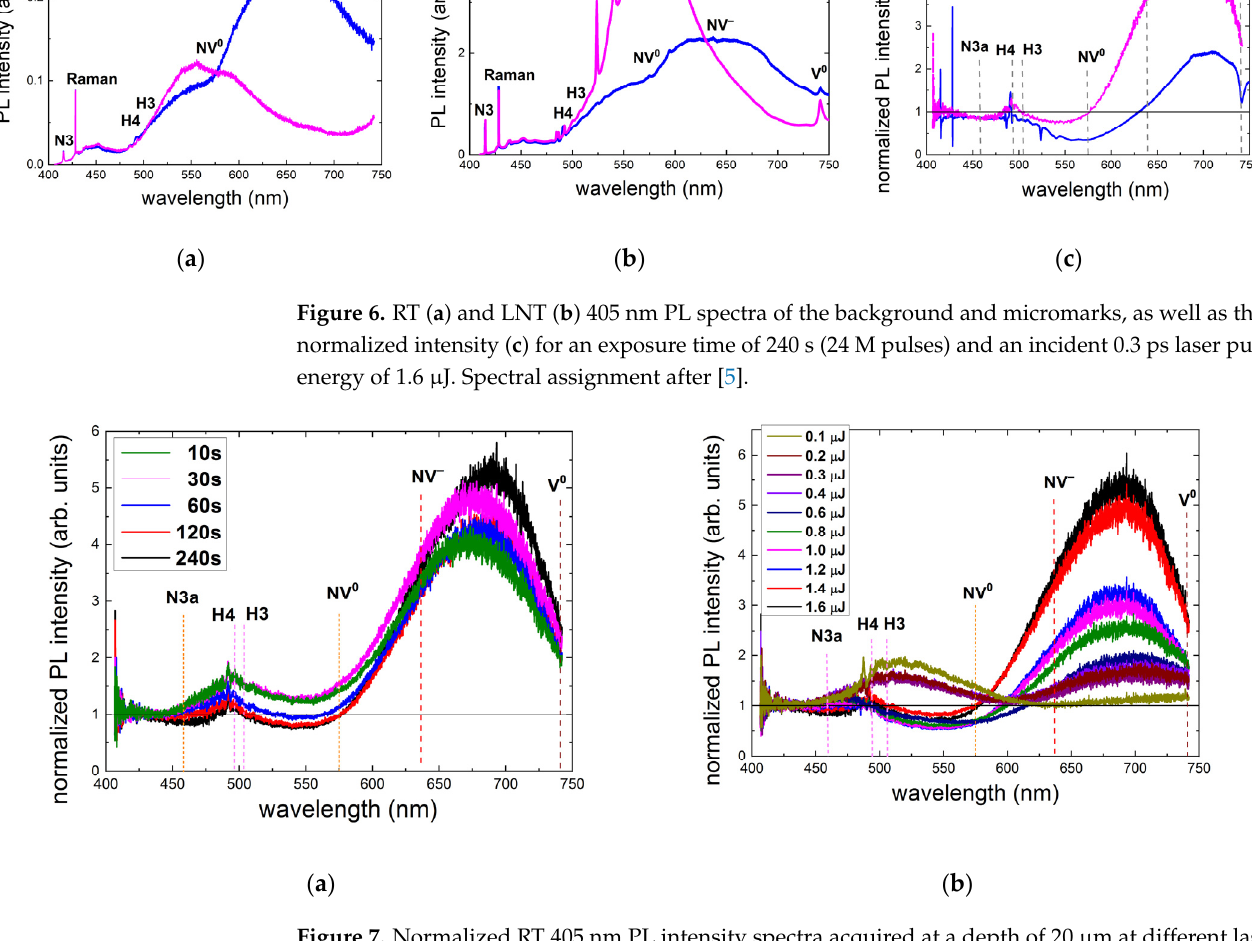
Figure 7. Normalized RT 405 nm PL intensity spectra acquired at a depth of 20 μ m at different laser exposures of 1–24 M pulses (( a ) pulse energy—1.6 μ J) and energies in the range of 0.1 to 1.6 μ J (( b ) an exposure time of 240 s—24 M pulses). Spectral assignment after [5].